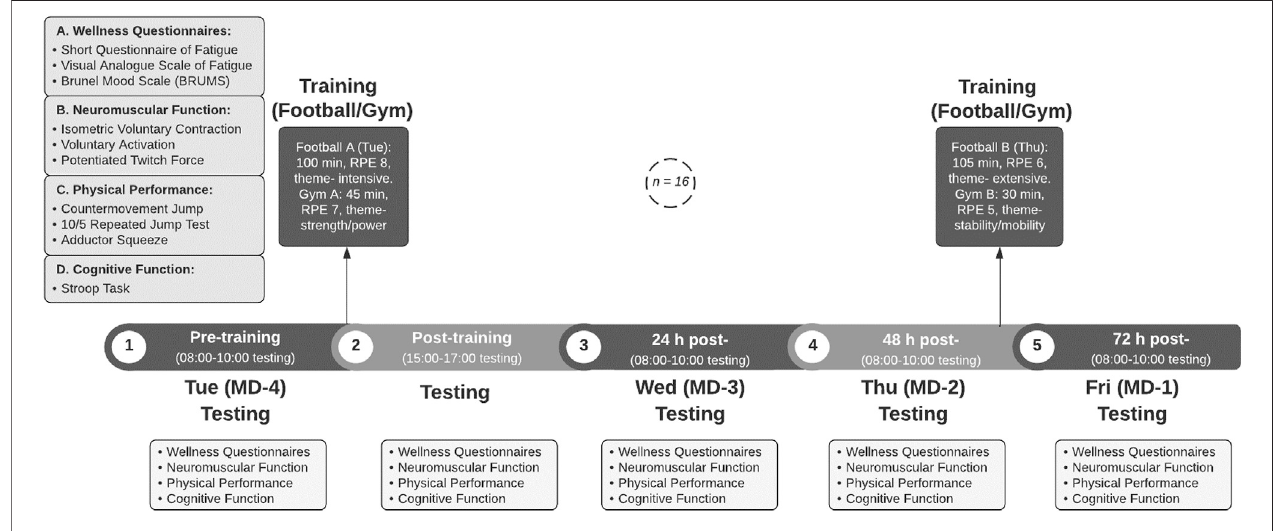
FIGURE 1 | Schematic of experimental testing and training